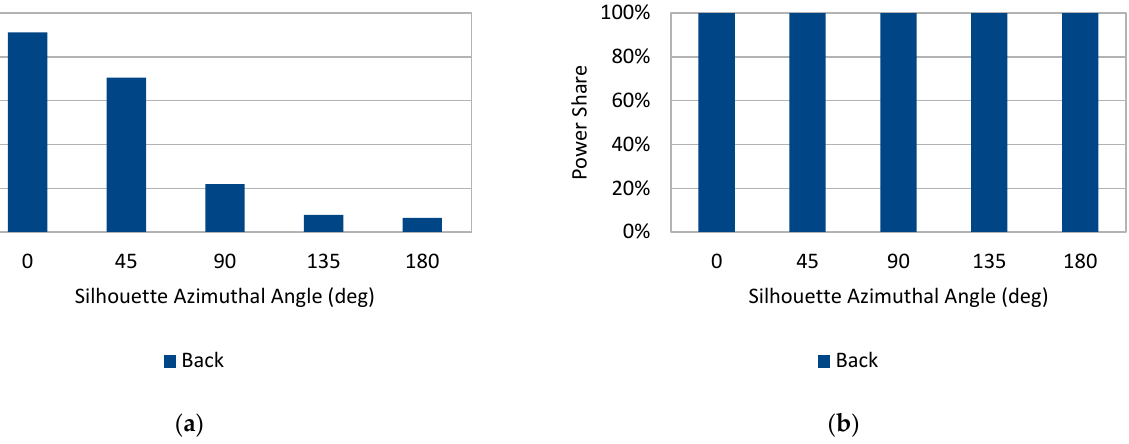
Figure 14. Measurement results for the curved rollable PV sheet as functions of the azimuthal angle of the silhouette: ( a ) Power delivered by each PV module; ( b ) Power share of each PV module.